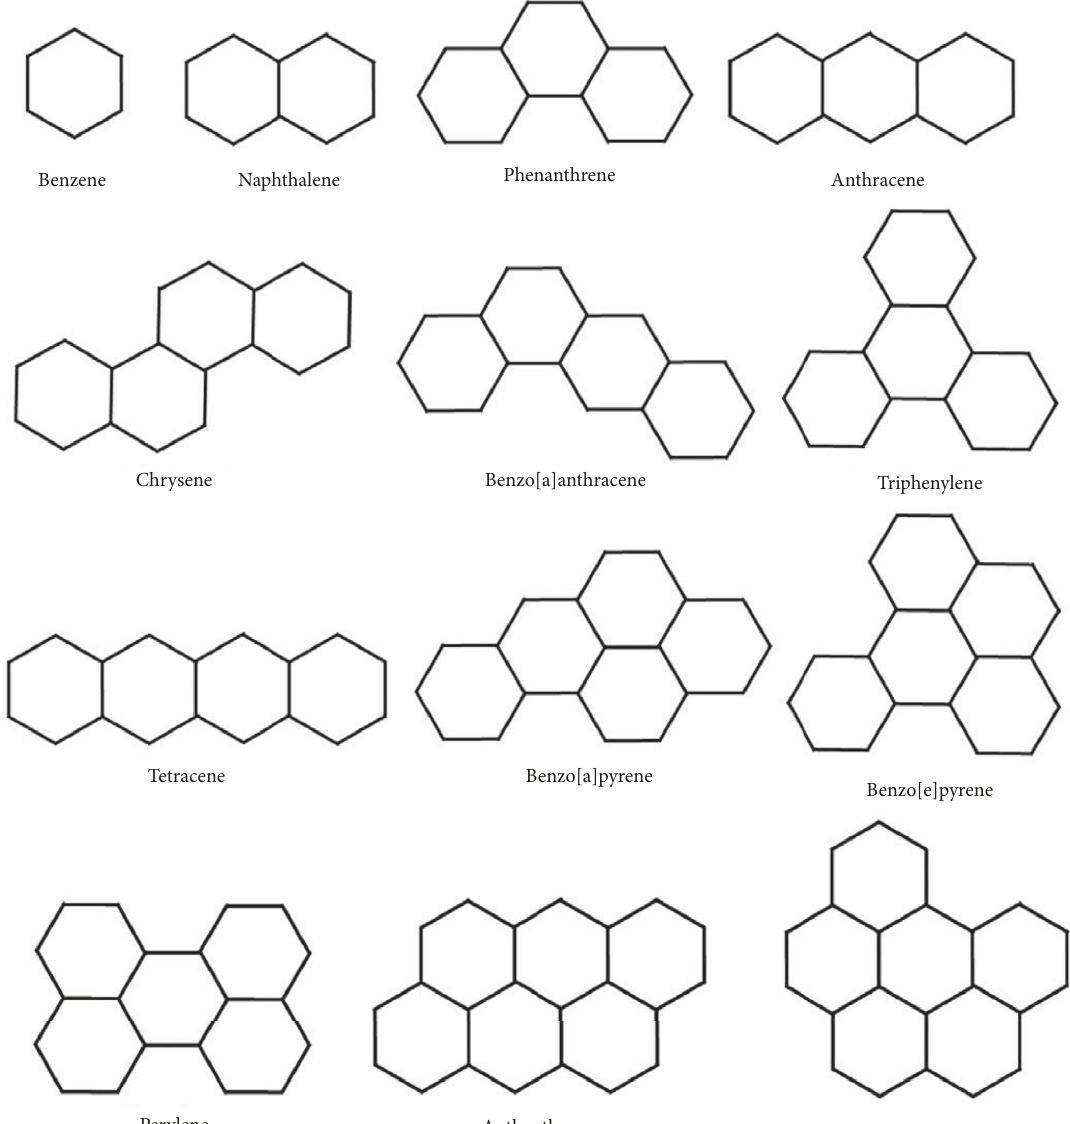
Figure 3: An illustration of benzene derivatives for the first